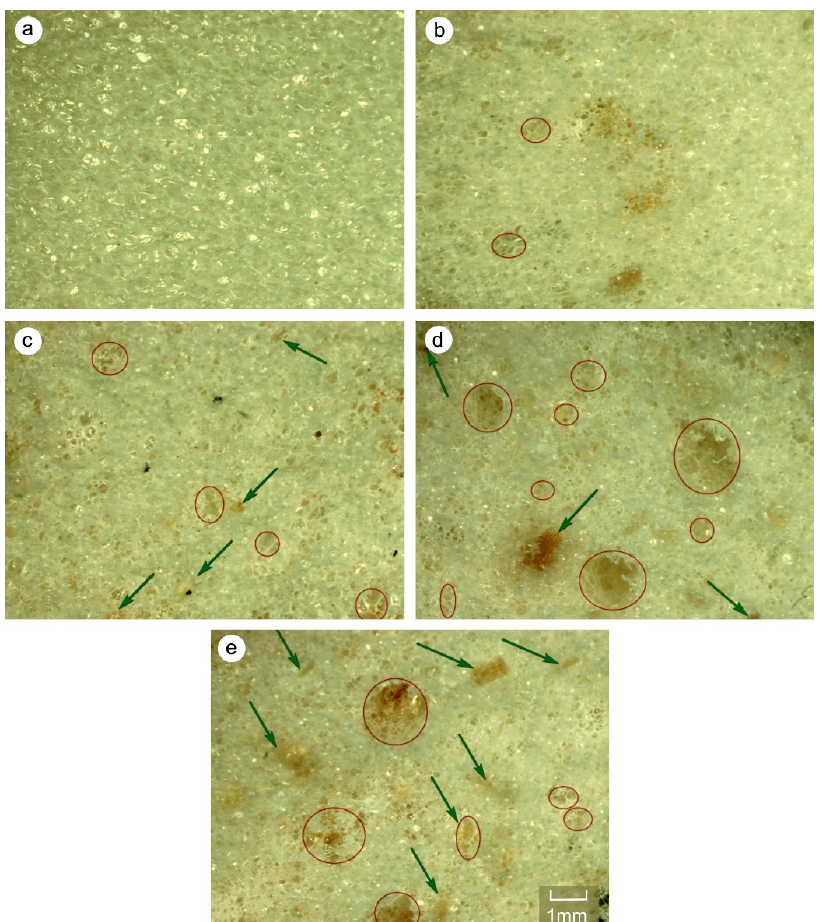
Figure 8. Light microscope photos of PUR samples with addition of different amount of WP: ( a ) control; ( b ) 5%; ( c ) 10%; ( d ) 15%; ( e ) 20% (green arrow—wood particles; red circle—structure disorders, large pores). All scale bars of figures are the same.